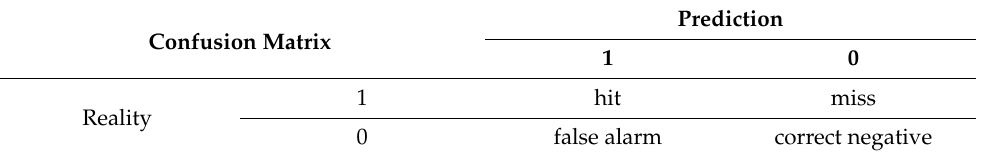
Table 2. Precipitation test